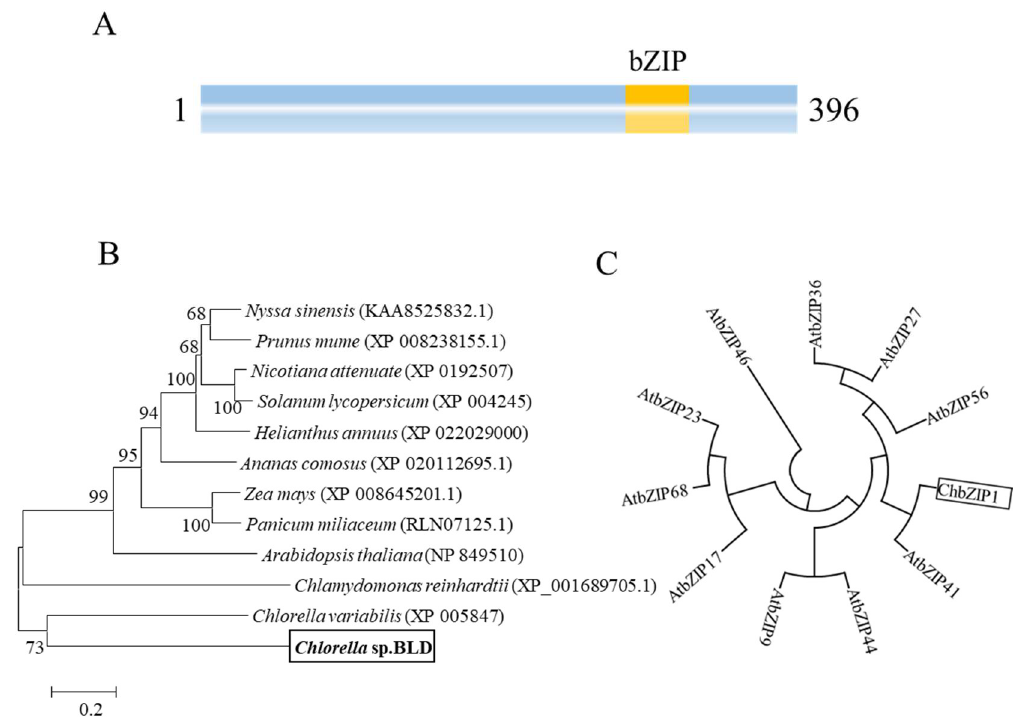
Figure 3. Phylogenetic and sequence analyses of ChbZIP1 from Chlorella sp. BLD. ( A ) Schematic representation of ChbZIP1 with basic leucine zipper (bZIP) domain. ( B ) Neighbor-joining phylogenetic relationships among ChbZIP1 from Chlorella sp. BLD and various bZIPs from other species. Bootstrap values were calculated at 1000 ties. Chlorella sp. BLD is indicated in boldface in box. ( C ) Neighbor-joining phylogenetic relationships among ChbZIP1 and ten groups of bZIP families in Arabidopsis . Box indicates ChbZIP1.